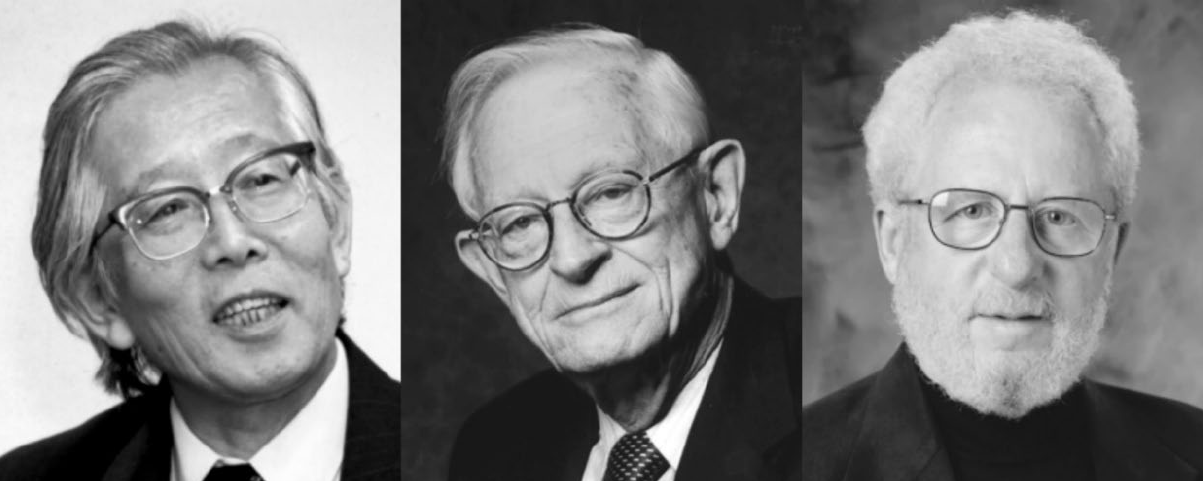
Figure 1. Hideki Shirakawa (b. 1936), Alan G. MacDiarmid (1927-2007), and Alan J. Heeger (b. 1936) [Reproduced from Ref. 20 with per- mission of the Royal Society of